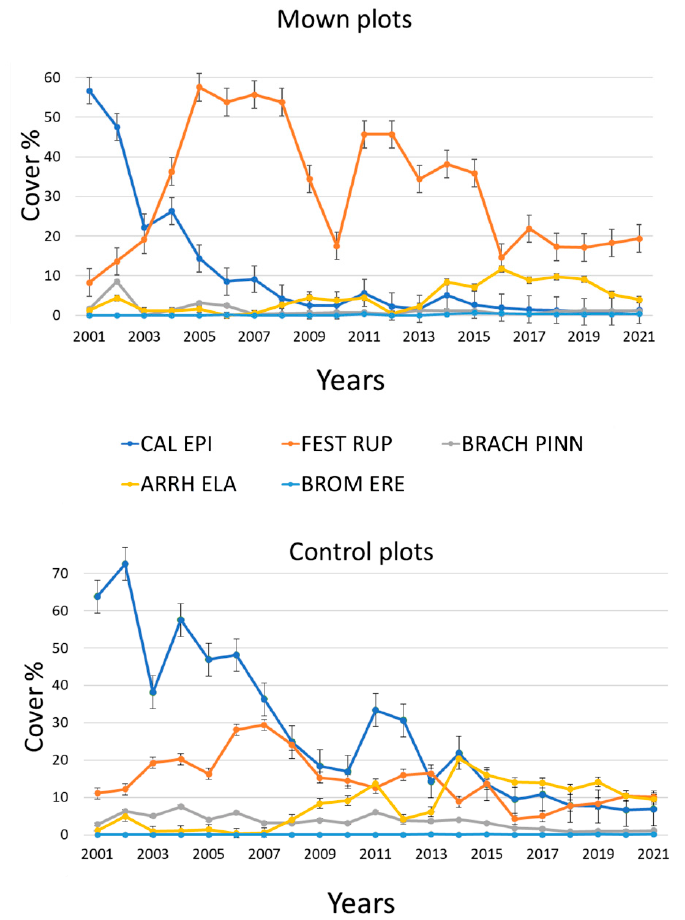
Figure 2. Changes in the cover of main grass species over time in treated and untreated plots. Abbreviations: CAL EPI = Calamagrostis epigejos , FEST RUP = Festuca rupicola , BRACH PINN = Brachypodium pinnatum , ARRH ELA = Arrhenatherum elatius , BROM ERE = Bromus erectus. With the recession of C. epigejos , a window of opportunity appeared for other grass species. Festuca rupicola demonstrated a particularly spectacular expansion in the mown plots in 2004. In the control plots, the C. epigejos–Festuca rupicola switch occurred much later, in 2019, and the cover of Arrhenatherum elatius surpassed that of Festuca rupicola, suggesting that in the absence of treatment, succession moved towards a more mesophyll state of hay meadow, with mowing, the cover of dry grasses increased. The species Brachypodium pinnatum and Bromus erectus were present in the study area, but they did not reach considerable abundance during the experiment (Figure 2). Both mowing and time had a significant effect on the cover of Festuca rupicola . Mowing treatment had the largest effect. The interaction of time and treatment was also significant (Table 3). Table 3. Results of repeated measures ANOVA of Festuca rupicola cover . Asteriks indicate statistical significance. Treatment